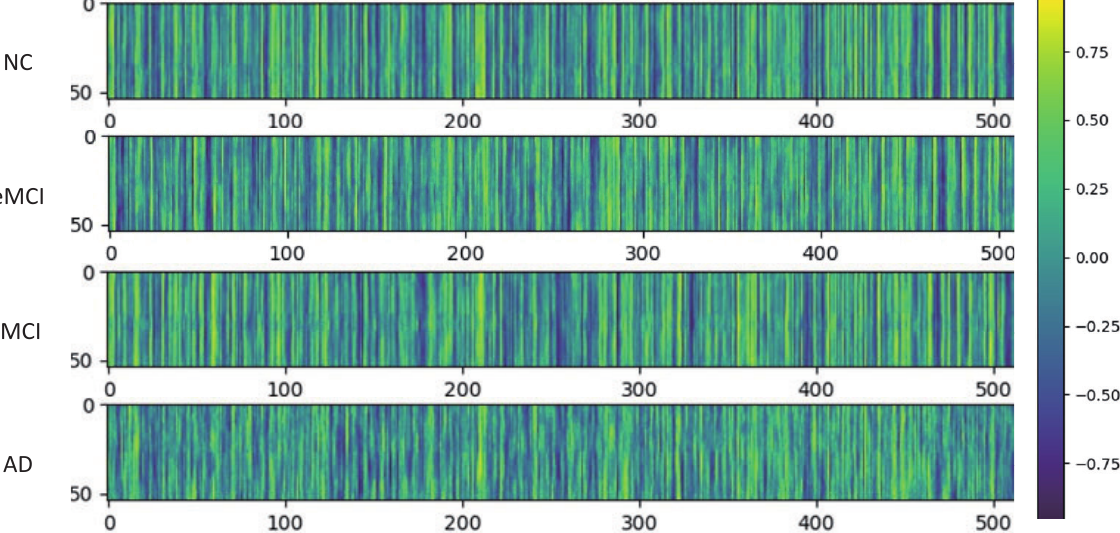
Figure 3. The latent space representation obtained by training the four classification models. The latent space representation of the dFC extracted by autoencoder. The color indicates the value of the